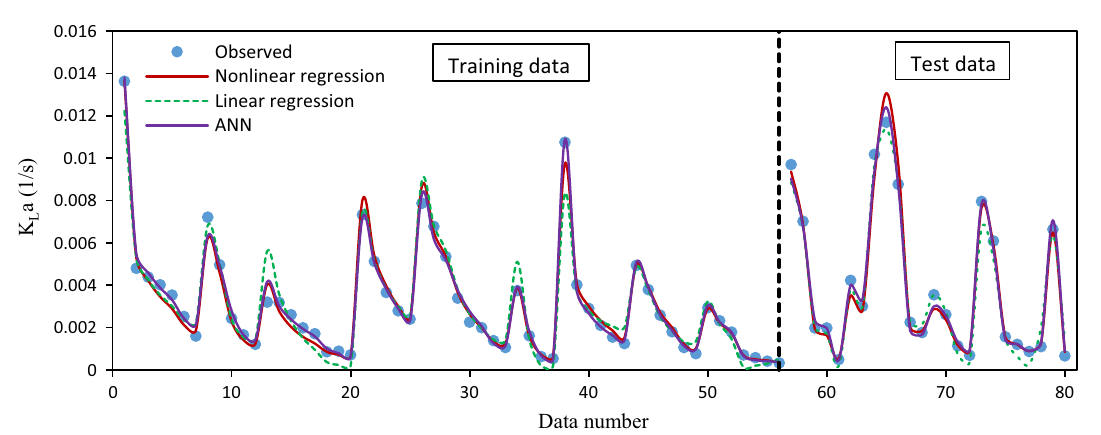
Table 4 Detail of performance evaluation parameters using regression and ANN models of the data set